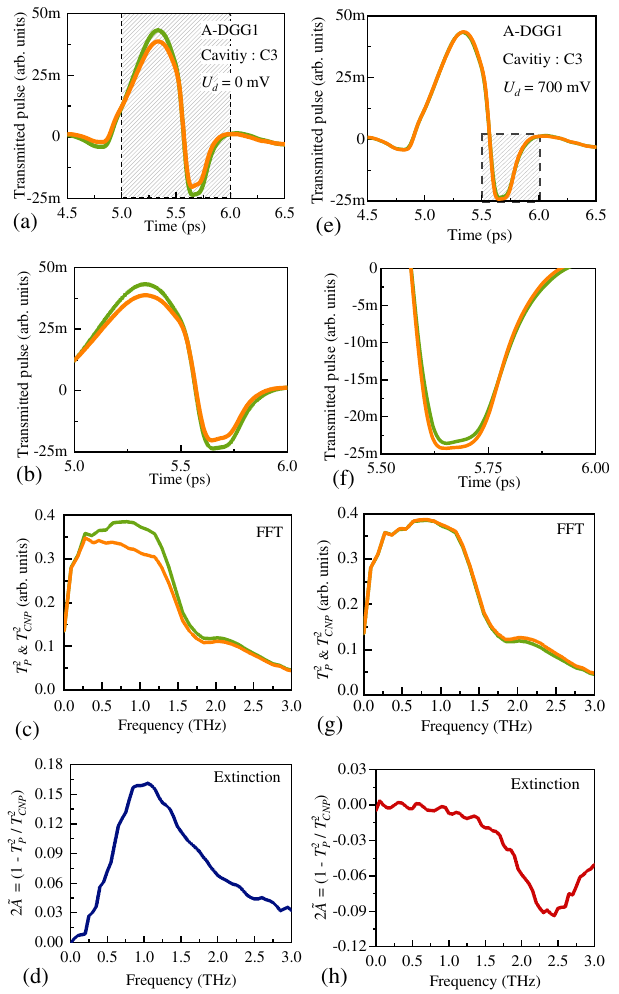
FIG. 4. Typical time traces obtained for the A-DGG1 sample with (orange) and without gate biasing (green). Left panels (a) – (c) are experiments without drain-source biasing ( U and right panels (e) – (g) the results obtained with a strong drain ¼ 700 mV. (b) and (f) are a magnification of the biasing at U d shadowed regions in (a) and (e), respectively. One can observe that the drain-source biasing inverses the order of magnitude of orange and green traces in the time traces and spectra row data. (d) and (h) show spectra obtained by Fourier transform for time traces with and without gate biasing, ffiffiffi p 2 πσ ϵ (see Refs. [49,50], and the discussion in Sec. A 1 =c of Supplemental Material [51]). Here, ϵ is the dielectric constant of the surrounding media.